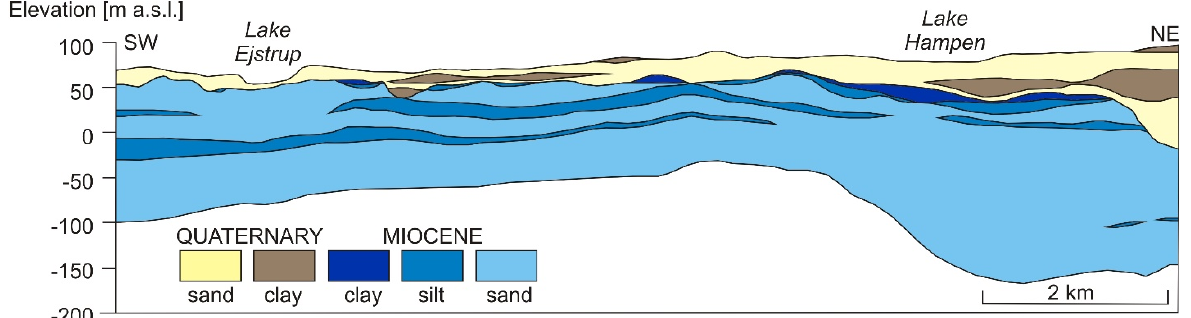
Figure 2. Data sets used in the setup of the geological model of the groundwater catchment. The cross-section through the geological model is shown in Figure 3.